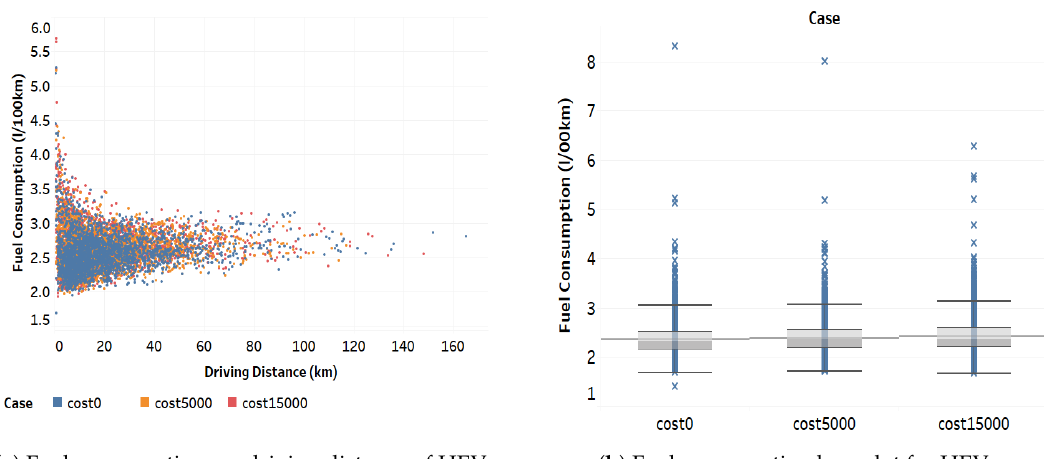
Figure 5. Fuel consumption distribution of